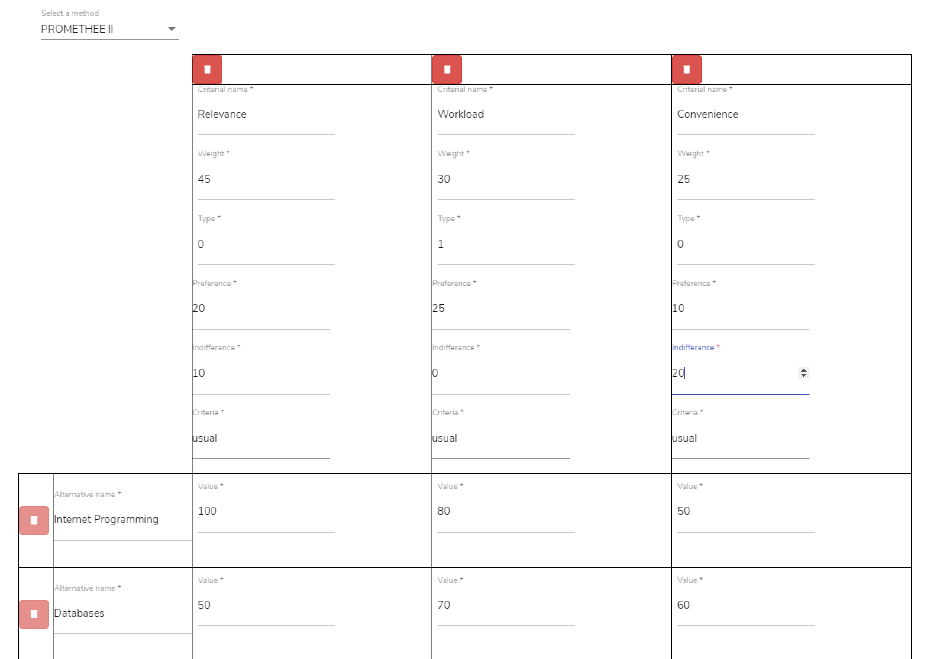
Figure 10. Multi-Criteria Decision Support input for skill introduction in a course.